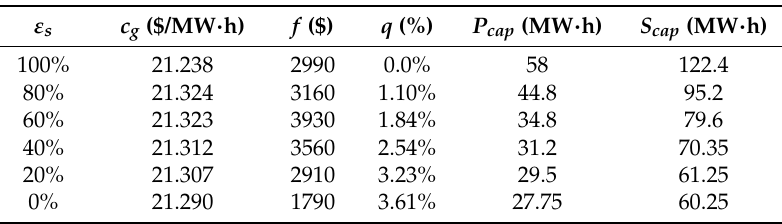
Table 6. Optimal results under different reserve level of